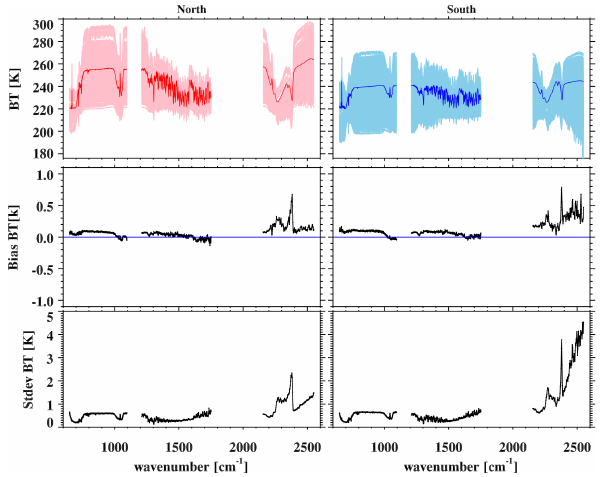
Figure 9. CrIS spectral distribution (top) for CrIS–IASI/A north SNOs (left) and south SNOs (right) and the mean (middle) and stan- dard deviation (bottom) of CrIS–IASI/A BT differences. The solid lines in the top figure represent the average spectrum from all the samples.